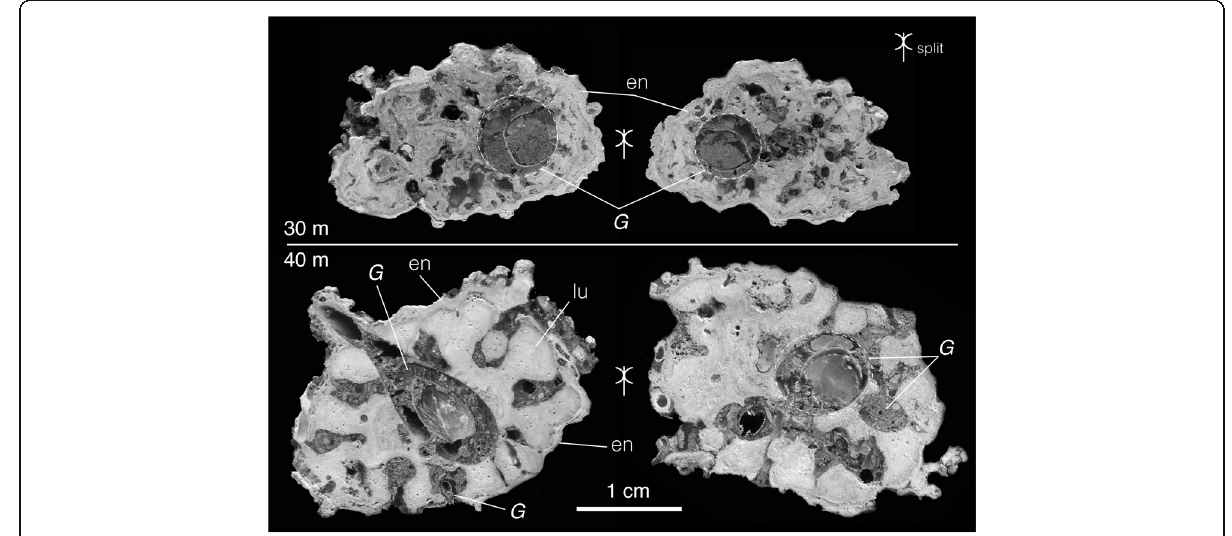
Fig. 6 Slab surfaces of two splitted rhodoliths showing their inner arrangement and the trace fossils; Cabo de Gata. Each rhodolith was cut in two parts through its center. Note that the Gastrochaenolites specimen ( G ; comparable to G. lapidicus Kelly and Bromley; dashed lines) still contains its producer boring bivalve ( Gastrochaena sp.), which grew in encrusting (en) and lumpy (lu) coralline growth forms. The rhodolith shape is not influenced by the boring-bivalve